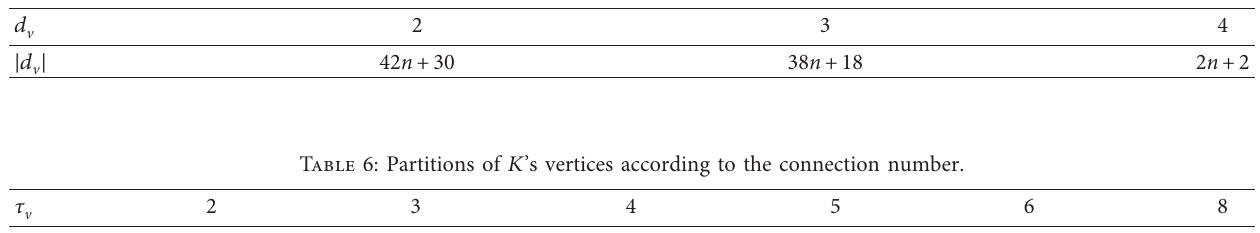
Table 5: Partitions of K ’s vertices according to the degree.